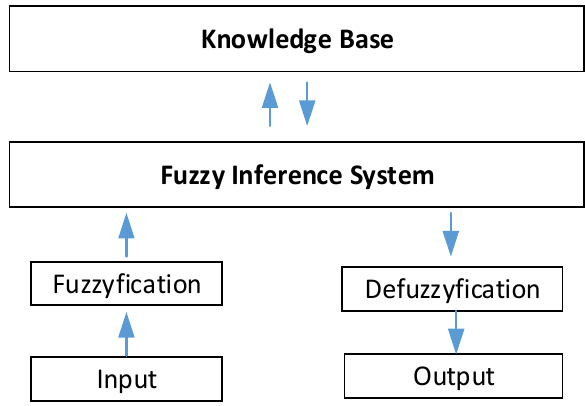
Figure 7. Model Fuzzy Interference System.